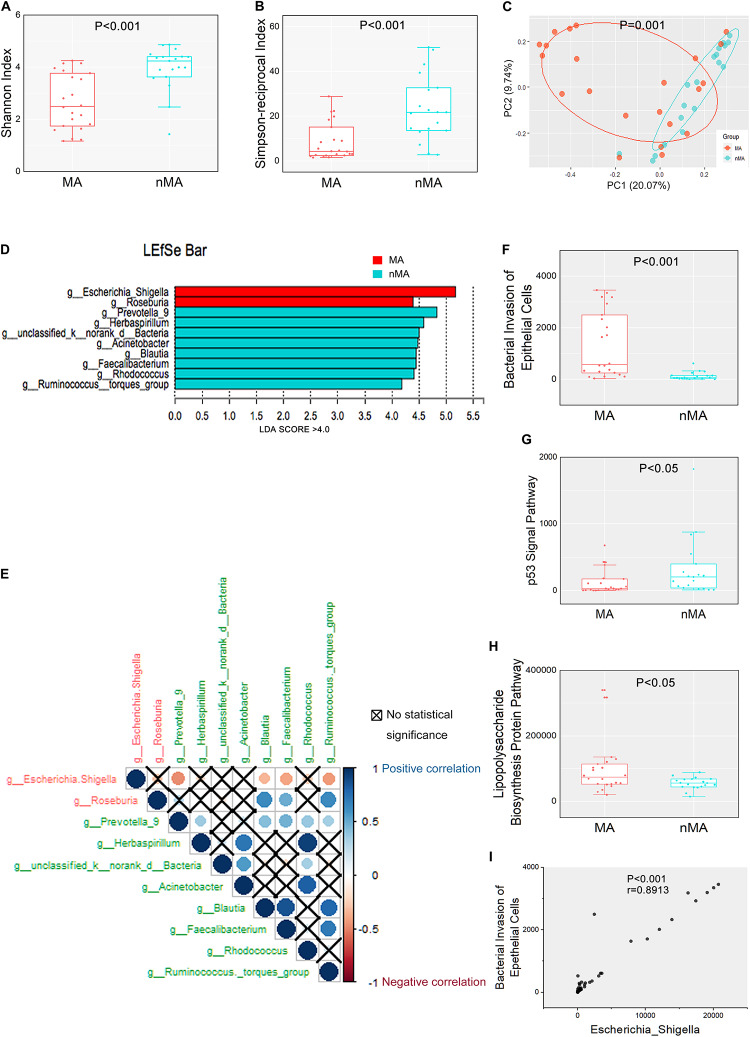
Mucosal microbiome diversity and communities are significantly different between MA and nMA. (A,B) α-diversity boxplot (Shannon and Simpson-reciprocal indices) of mucosal samples in MA and nMA groups. Boxes represented the 25th to 75th percentile of the distribution; the median was shown as a thick line in the middle of the box; whiskers extend to values with 1.5-times the difference between the 25th and 75th percentiles. (C) PCoA using Bray–Curtis of β-diversity in MA and nMA groups. (D) LDA score computed from features differentially abundant between MA and nMA in mucosal samples. The criteria for feature selection was log LDA score > 4. (E) Spearman correlations among two MA-enriched (red) and eight-nMA enriched (green) genera taxa in mucosal samples of CRC patients. Red dots indicated negative correlation, blue dots indicated positive correlation, cross indicated no significance (P > 0.05). (F–H) Boxplot of bacterial invasion of epithelial cells pathway, Lipopolysaccharide biosynthesis protein pathway, and p53 signal pathway between MA and nMA. P values were adjusted using the FDR correction. (I) Spearman correlation between bacterial invasion of epithelial cells pathway and relative abundance of Escherichia–Shigella.